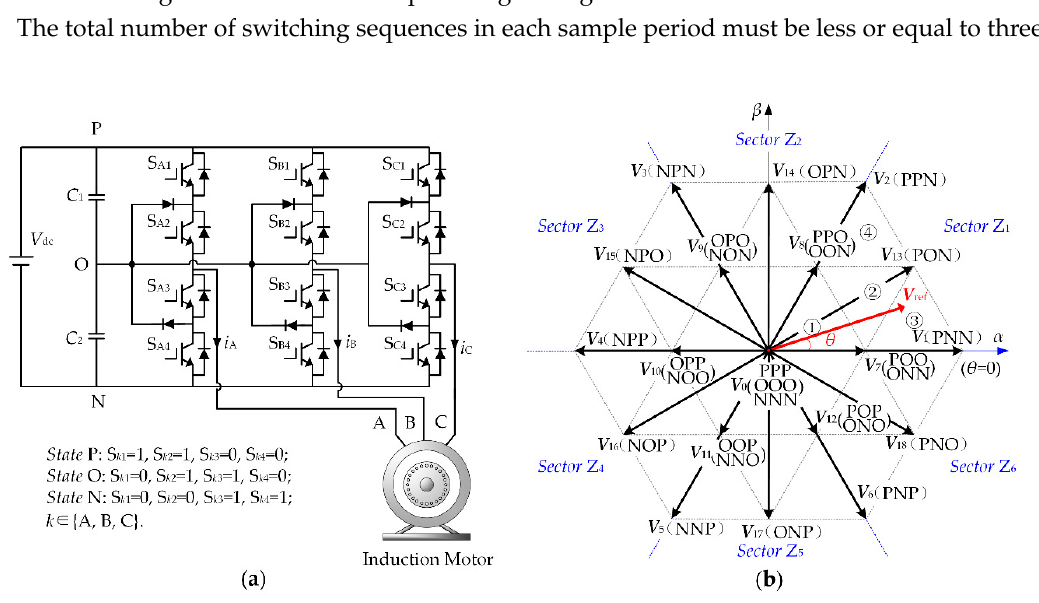
Figure 1. The topology of NPC three-level inverter and the space vector hexagon: ( a ) topology; ( b ) space vector hexagon.